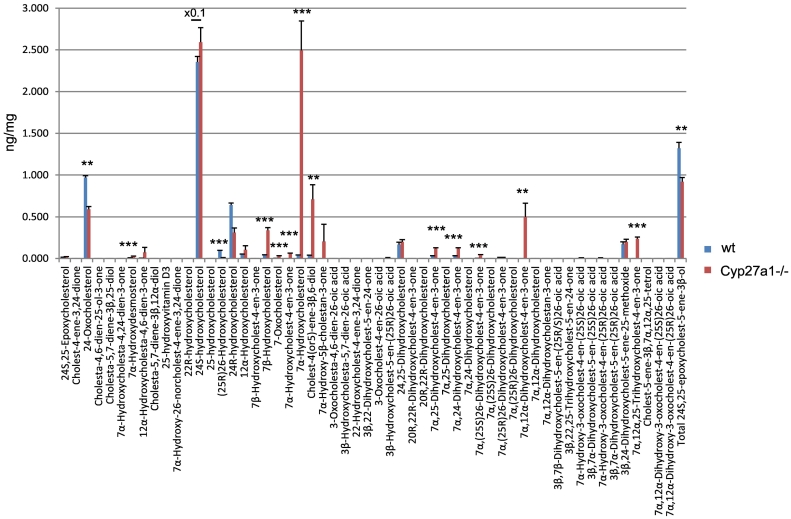
Concentrations of oxysterols and cholestenoic acids in Cyp27a1−/− (n = 3) and Cyp27a1+/+ (wt, n = 3) mouse brain. No hydrolysis or solvolysis steps were performed so the values reported are for “free” non-esterified molecules. Sterols are arranged according to mass and chromatographic order of elution of the GP-derivative. To maintain a single y-axis magnification factors have been applied as indicated. The low levels of di- and tri-hydroxycholesterols and of dihydroxycholestenoic acids in brain made it difficult to distinguish between these compounds and their 3-oxo equivalents using EADSA as their differentiation is based on peak area difference between samples treated with and without cholesterol oxidase. Hence, for these metabolites the combined values for the two structures are given, and for simplicity we just give values for di- and trihydroxycholest-4-en-3-ones and 7α-hydroxy-3-oxocholest-4-enoic acids. Using the EADSA method 24S,25-epoxycholesterol isomerises to 24-oxocholesterol, becomes hydrolysed to 24,25-dihydroxycholesterol and undergoes methanolysis to 3β,24-dihydroxycholest-5-ene-25-methoxide. The total 24S,25-epoxycholesterol corresponds to the sum of the individual forms.